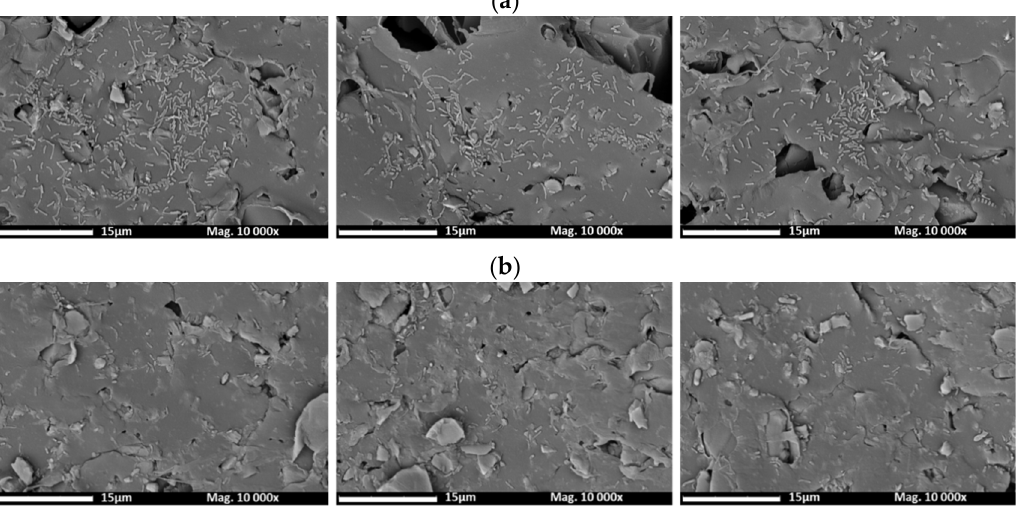
Figure 5. Images of the top surface of the membranes (taken in three different zones) obtained by SEM: ( a ) unmodified membrane with Aeromonas ; ( b ) modified membrane with Aeromonas .